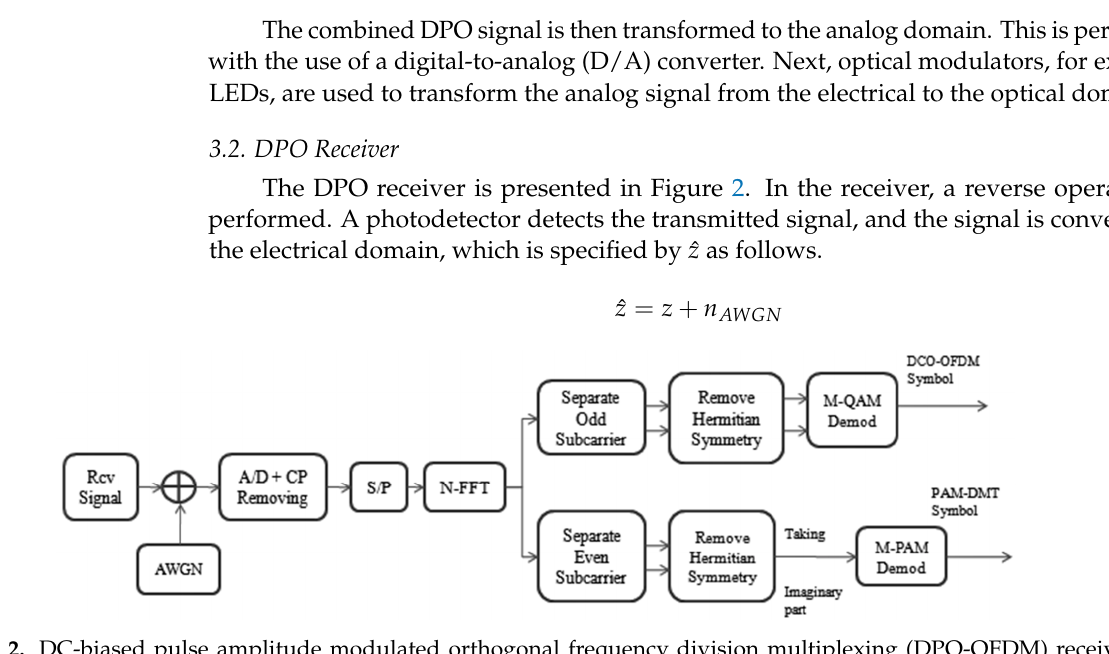
Figure 2. DC-biased pulse amplitude modulated orthogonal frequency division multiplexing (DPO-OFDM) receiver transforms the optical signal into electrical and then separates the dc-biased optical OFDM (DCO-OFDM) and pulse amplitude modulated discrete multitone (PAM-DMT) components. Note that Rcv stands for received, while A/D, CP, S/P and IFFT stand for analog-to-digital, cyclic prefix, serial-to-parallel, and inverse fast Fourier